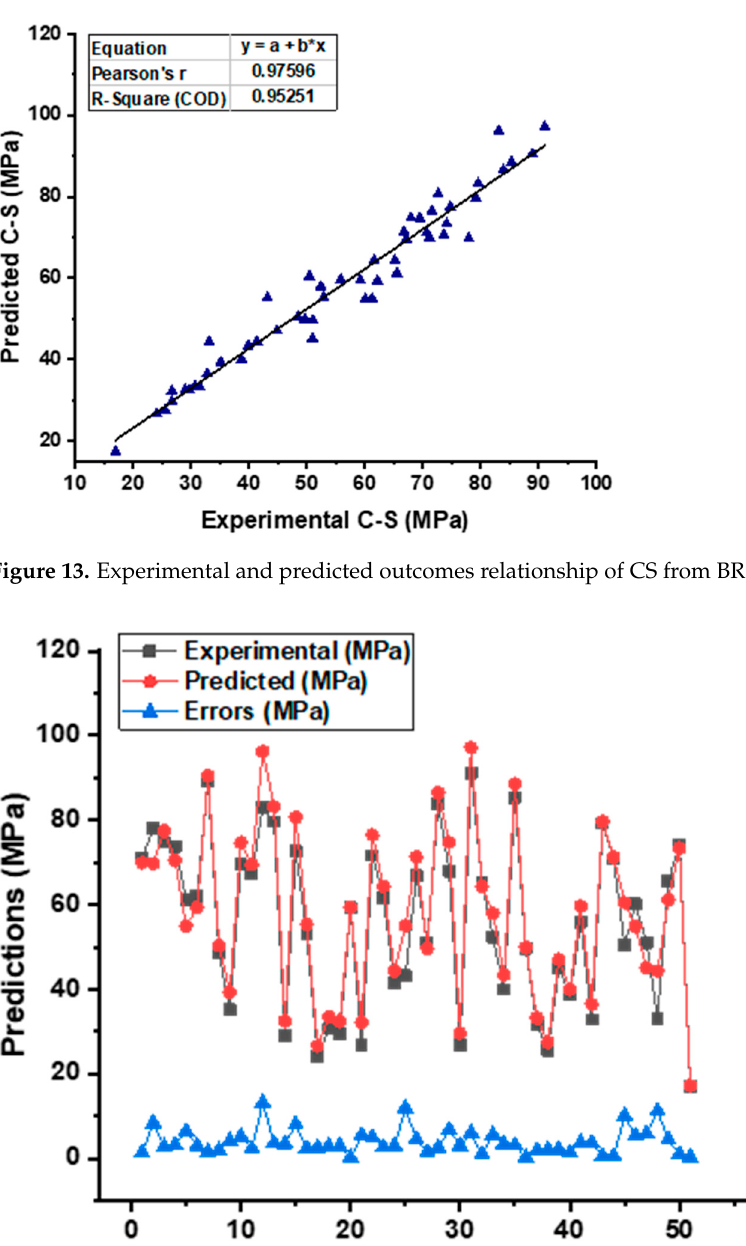
11 of 21 Figure 12. Box plot for predicted and experimental outcomes from SVM model. 5.3. BR Model Outcome As can be seen in Figure 13, the output of the bagging model demonstrates a strong and better relationship with the experimental CS result of the self-compacting concrete than the predictions of the MLP and SVM models, and it gives an R 2 value of 0.95. This is in contrast to the predictions of the MLP and SVM models. Figure 14 also provides a visual representation of the error’s distribution, which is an additional point of interest. The variation produces data with a maximum of 13.05 MPa, a minimum of 0.16 MPa, and an